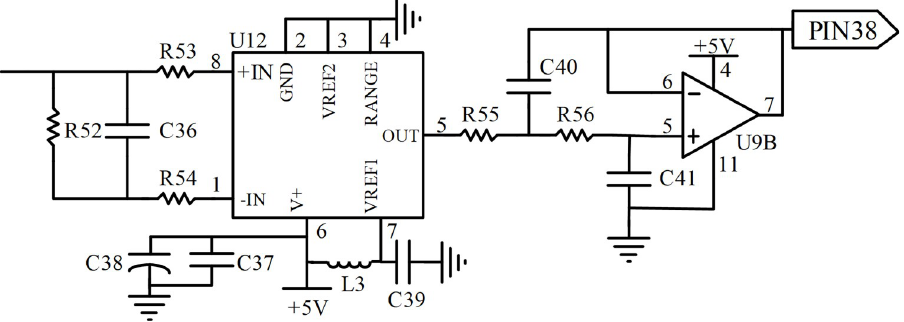
Fig 9. Schematic of current